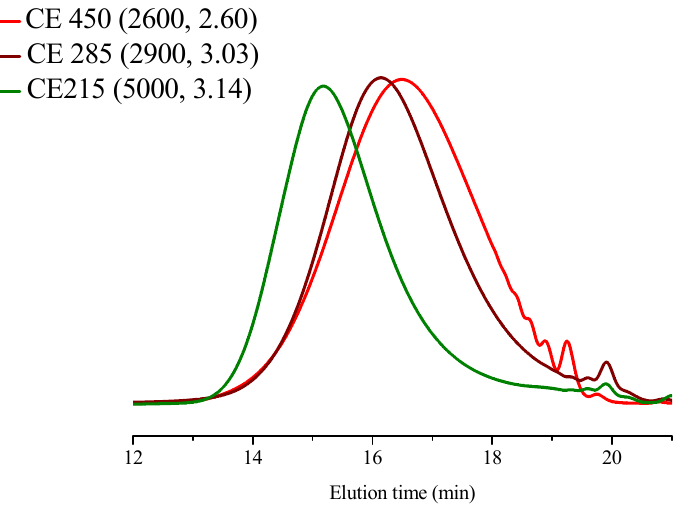
, Ð shown in parentheses). n